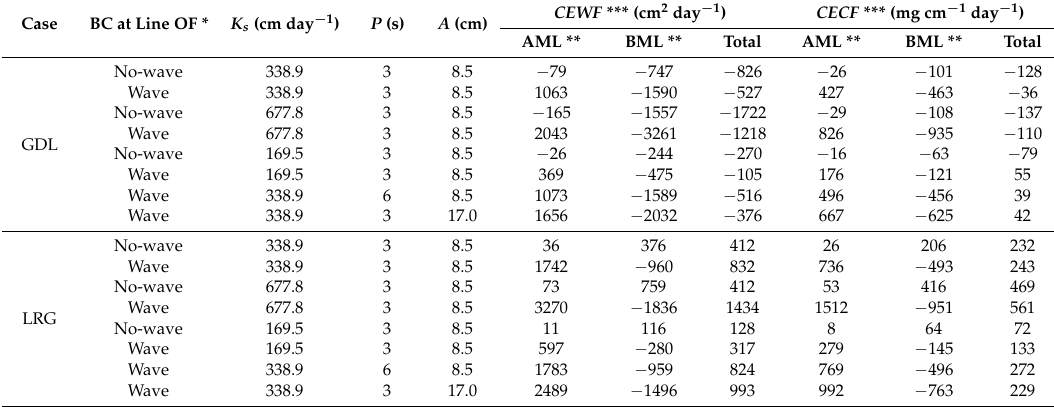
Table 2. Cumulative exchange water and chloride fluxes during a one-day period and sensitivity analysis due to the aquifer hydraulic conductivity ( K s ), the wave cycle period ( P ), and amplitude ( A